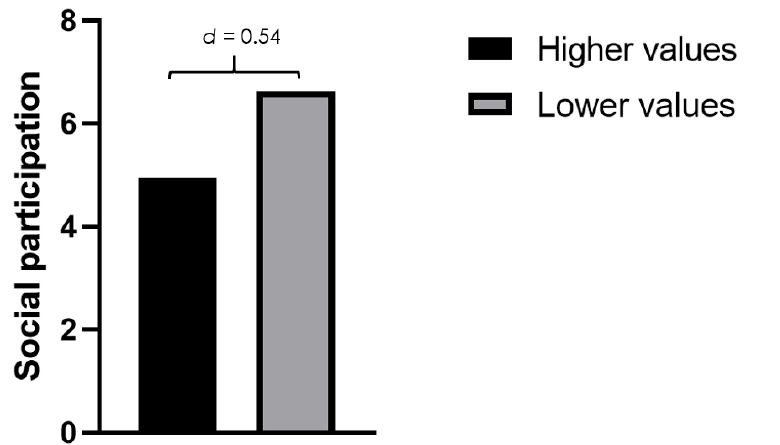
Figure 2. Social participation in participants with higher and lower levels of depression symptoms.